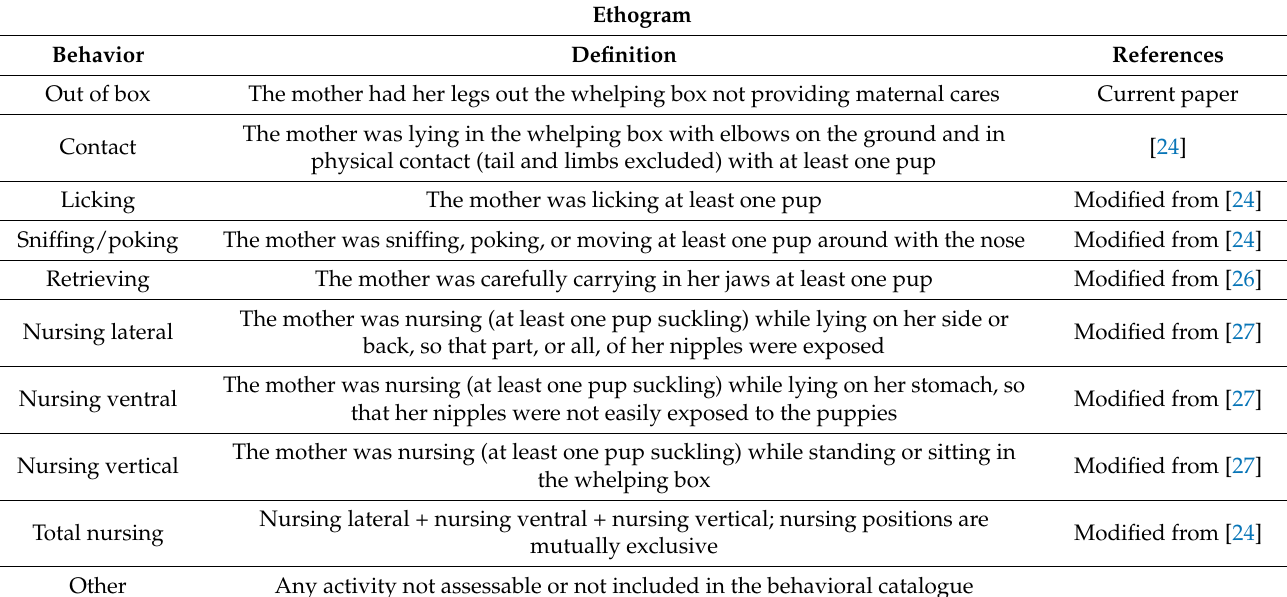
Table 2. Ethogram. The catalogue of maternal behaviors